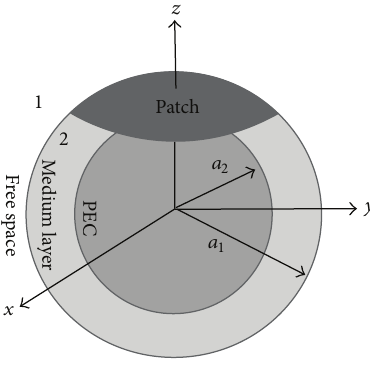
Figure 1: The microstrip antenna in a layered spherical